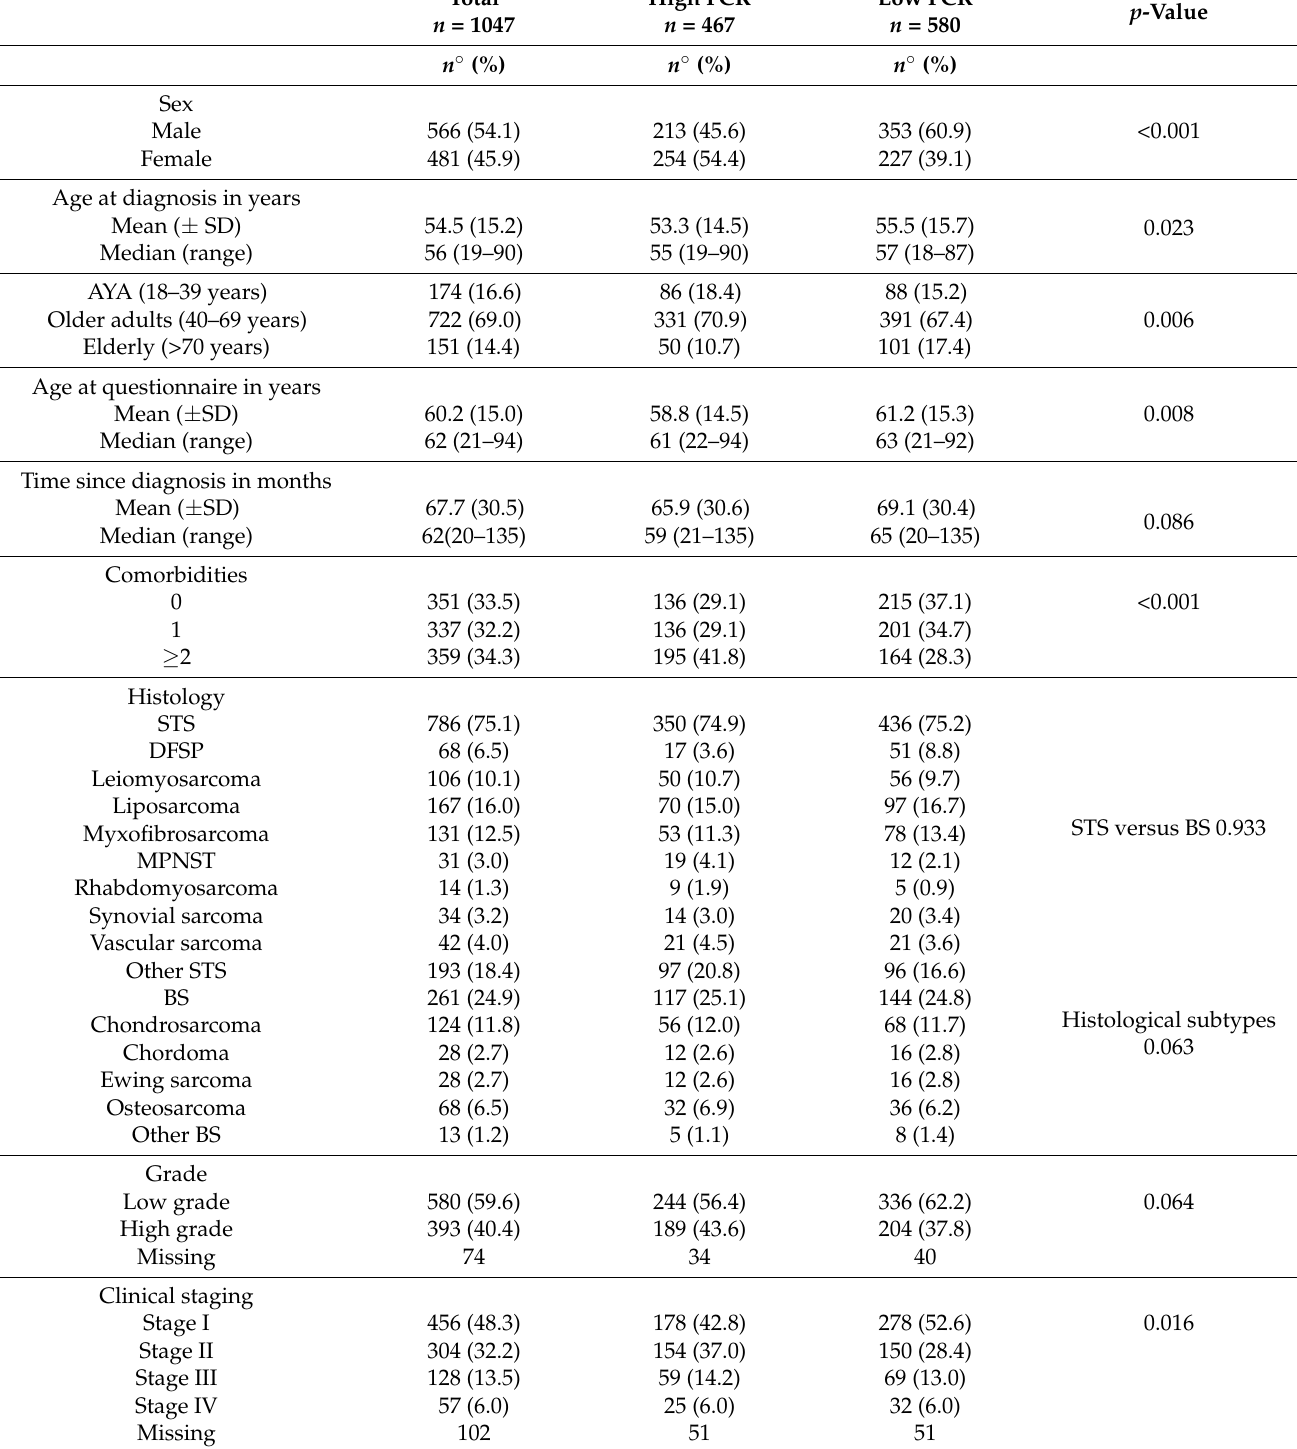
Table 1. Sociodemographic, tumour, and treatment